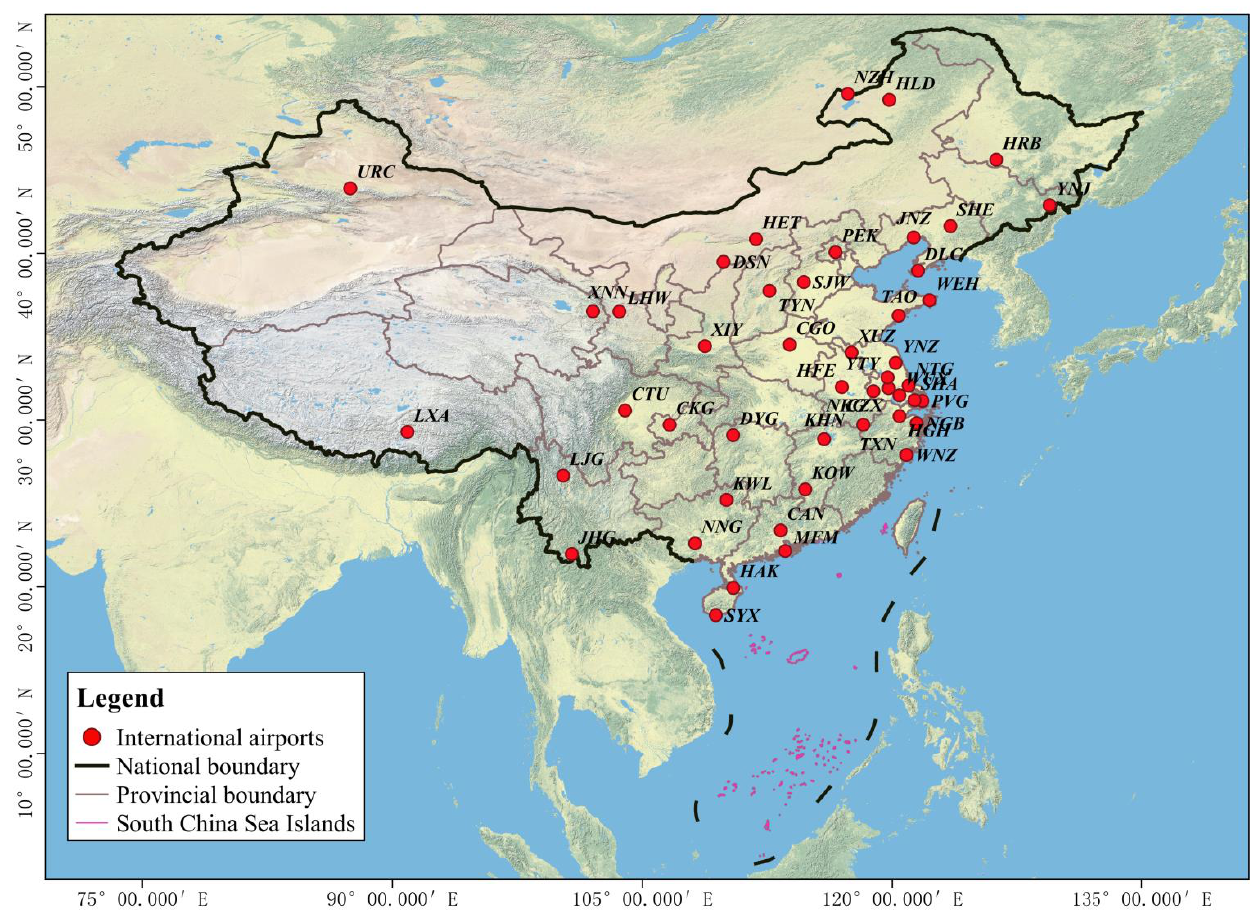
Figure 1. The geographic locations of the international airports in China. Table 1. Information of international airports in China.